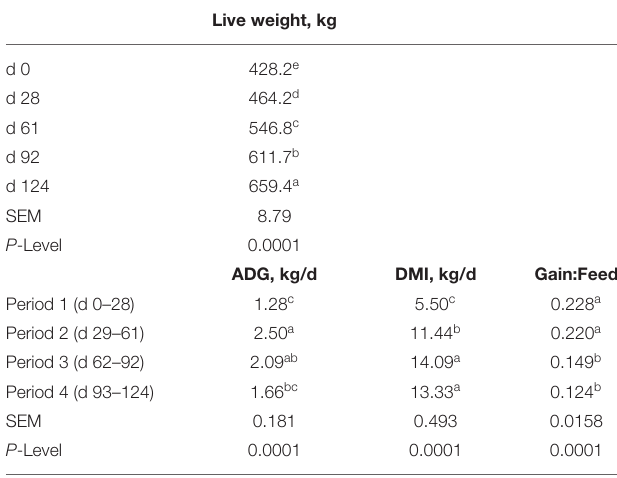
TABLE 2 | miR-122 sequence alignment for Bos taurus (bta), Ovis aries (oar), and Homo sapiens (hsa). miR-122 Mature Sequence (miRbase)